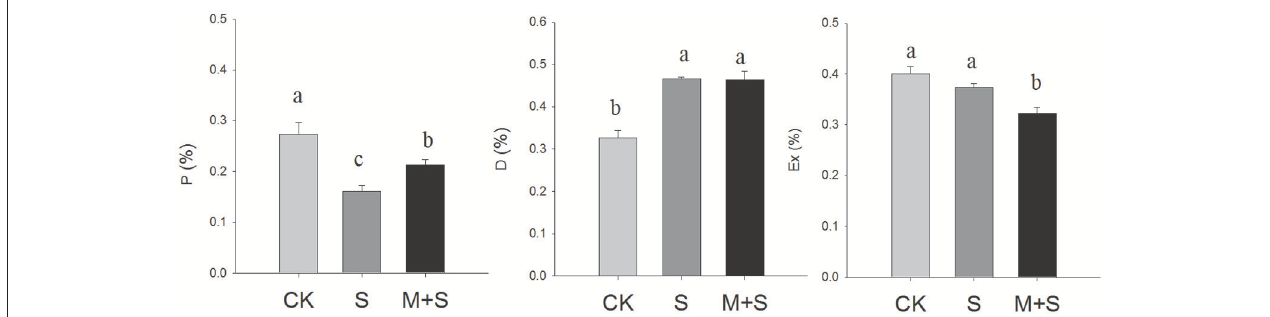
FIGURE 1 | Partitioning of absorbed light energy in tomato seedlings. P, reduced PSII photochemistry; D, antenna heat dissipation; Ex, excess energy in the reaction center during the photochemical reaction. The results were calculated from data for 12-day, salt-stressed leaves. CK, control; S, 150 mM NaCl; M + S, 150 µ M melatonin with 150 mM NaCl. Values represent the means ± SE ( n =